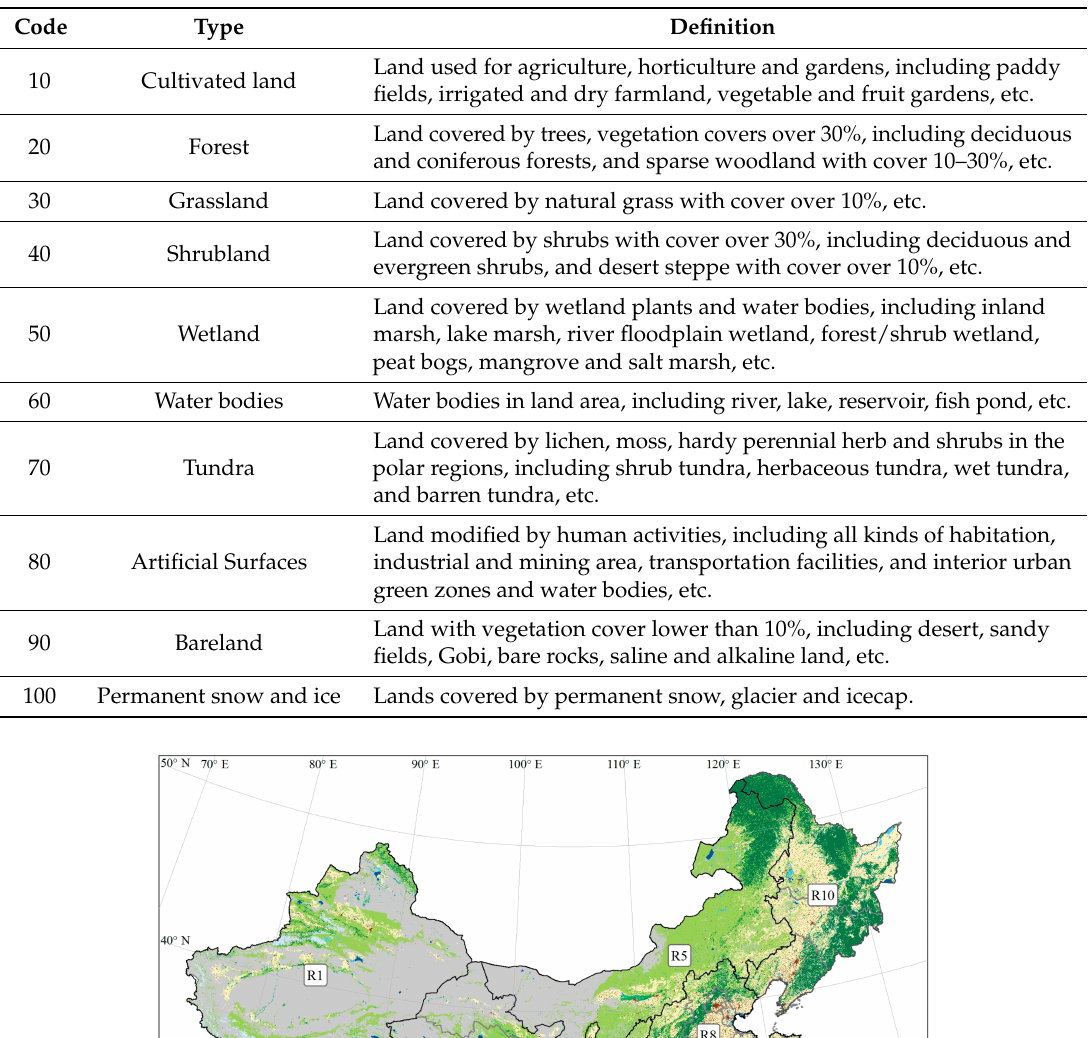
Table 1. Classification, codes, and definition of each land cover type of GlobeLand30.